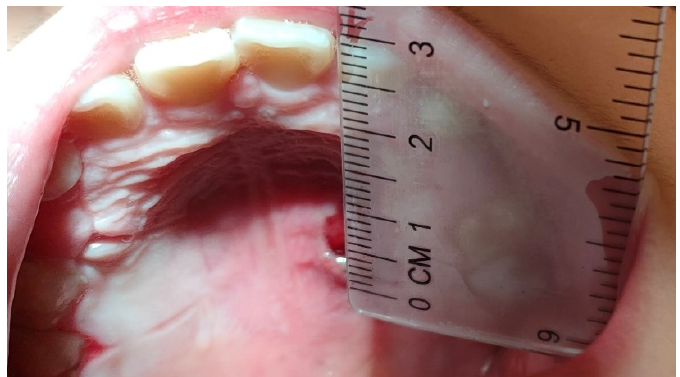
Figure 2. Photo Pre gel Test.